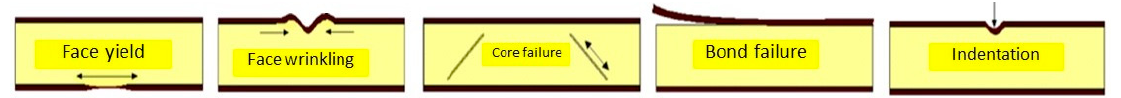
Figure 7. Major failures modes under bending and shear. Adapted from [28].